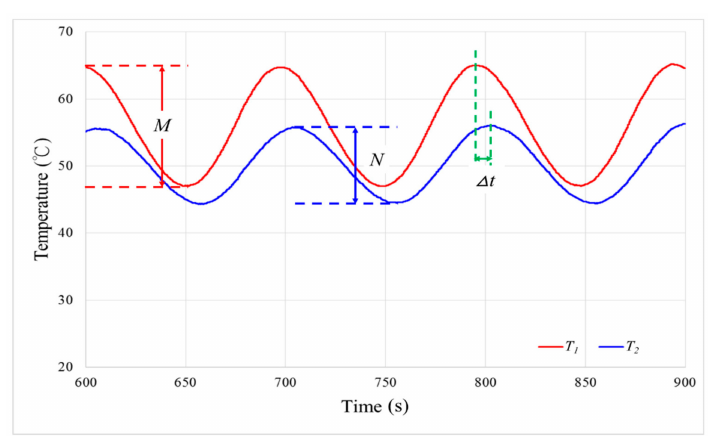
Figure 4. Temperature curve and experimental data